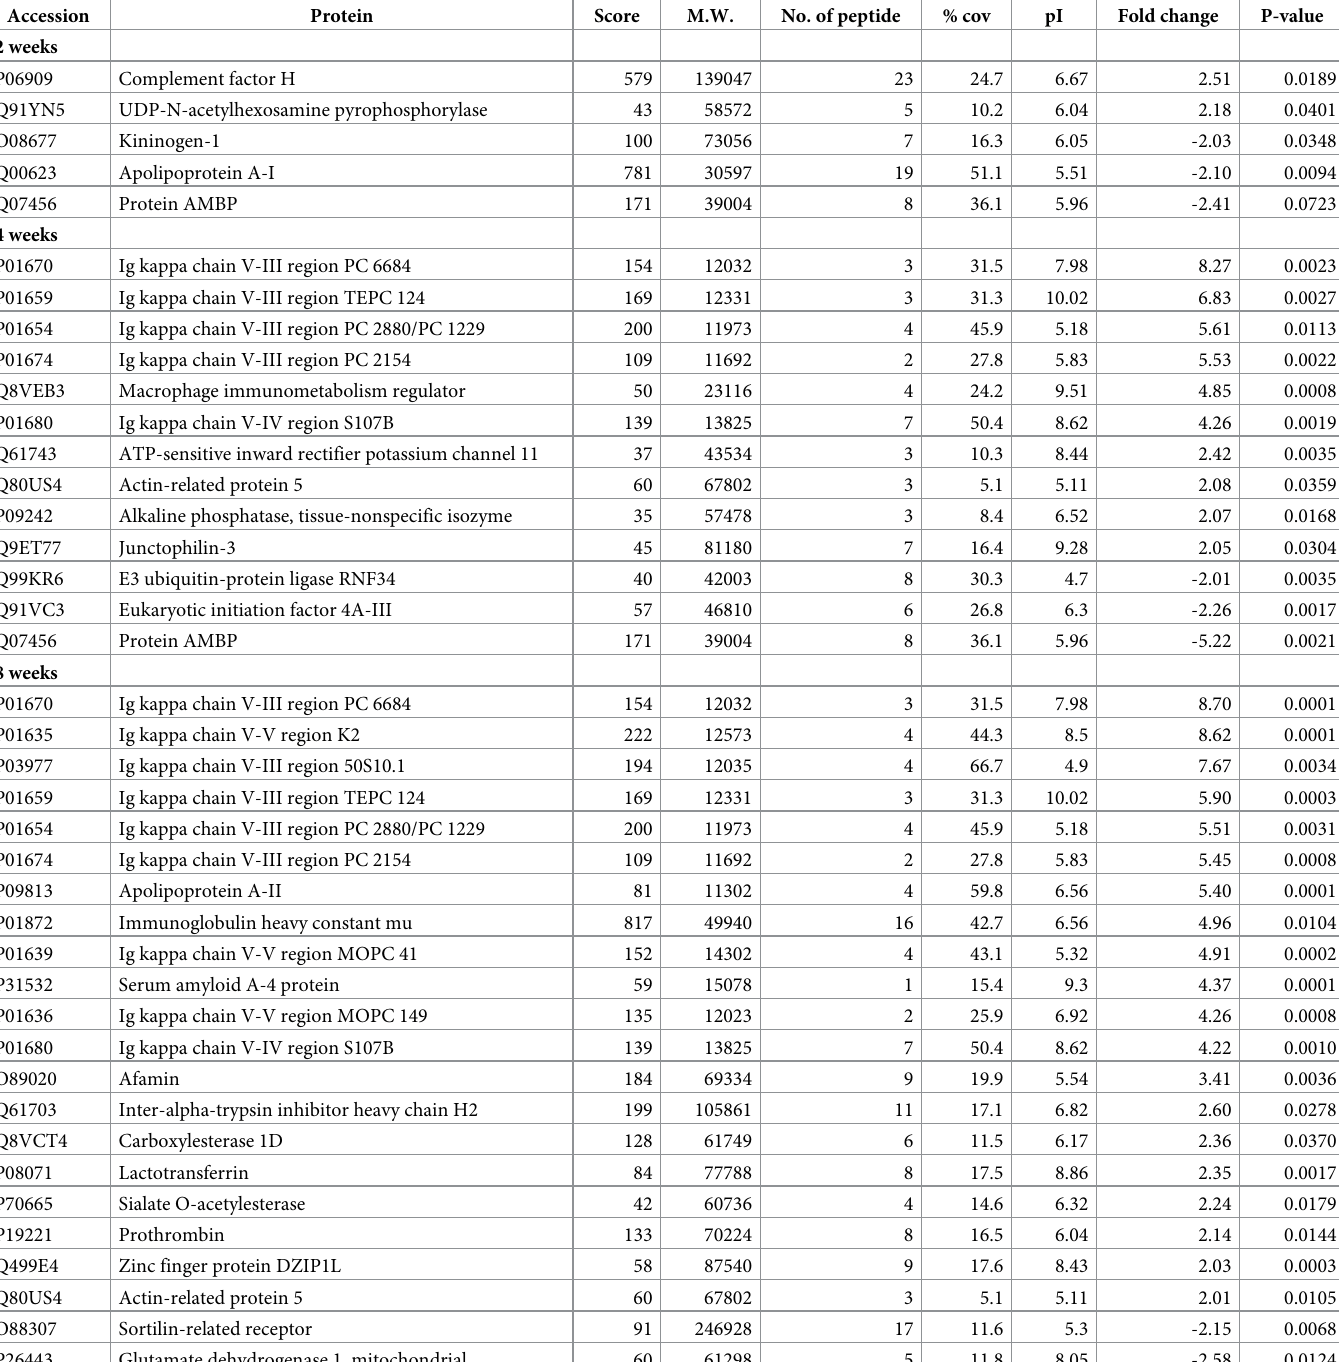
Table 1. Differential mouse serum protein at 2, 4 and 8 weeks after T . spiralis infection. The up-regulation or down-regulation of the mouse serum proteins expression levels were determined by comparison with uninfected sera using LC-MS/MS. The UniProt protein database was used with Mus musculus (house mouse) set as the taxon- omy filter. Only the significant differences (p-value � 0.05) were presented in this